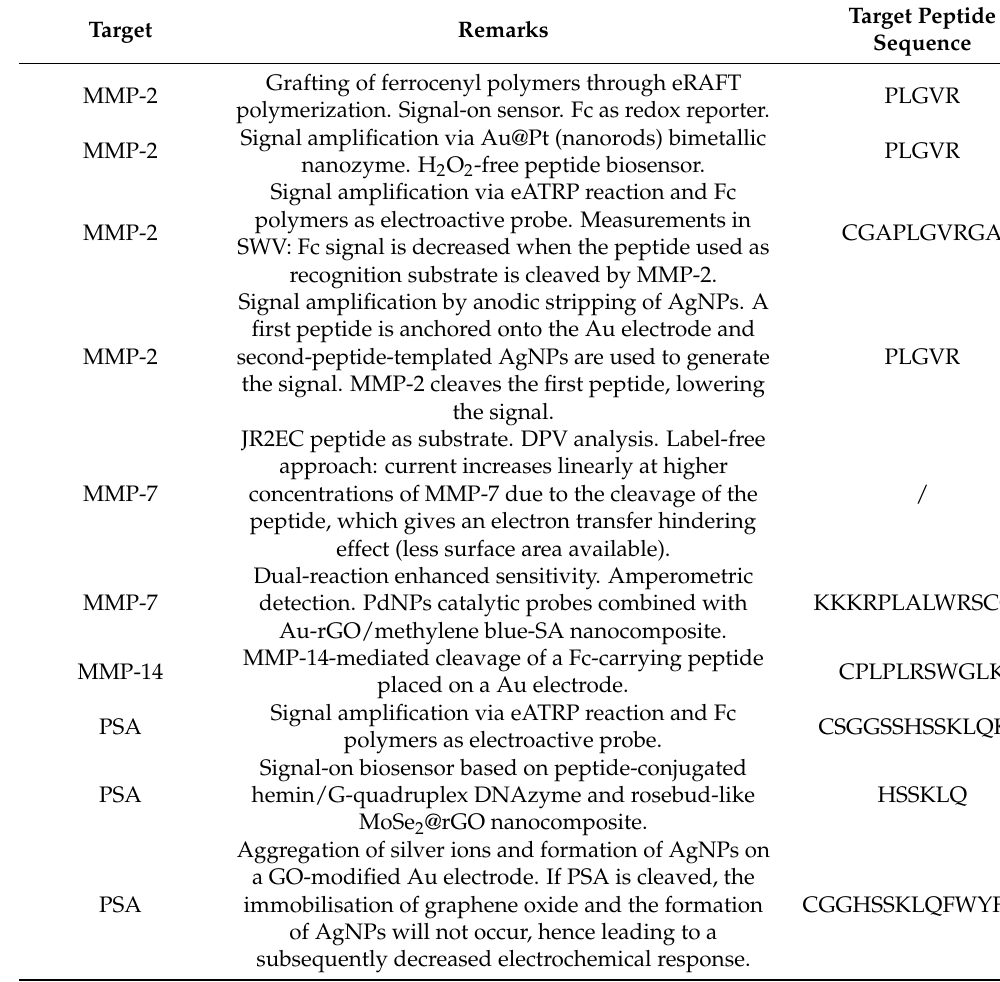
Table 1. Catalytic peptide-based biosensors for the detection of various proteases and kinases. GCE = glassy carbon electrode; NHS = normal human serum; SA = sodium alginate; EIS = electrochemical impedance spectroscopy; PEI = polyethyleneimine; PtNTs = platinum nanotubes; CFU = colony-forming unit; HNE = human neutrophil